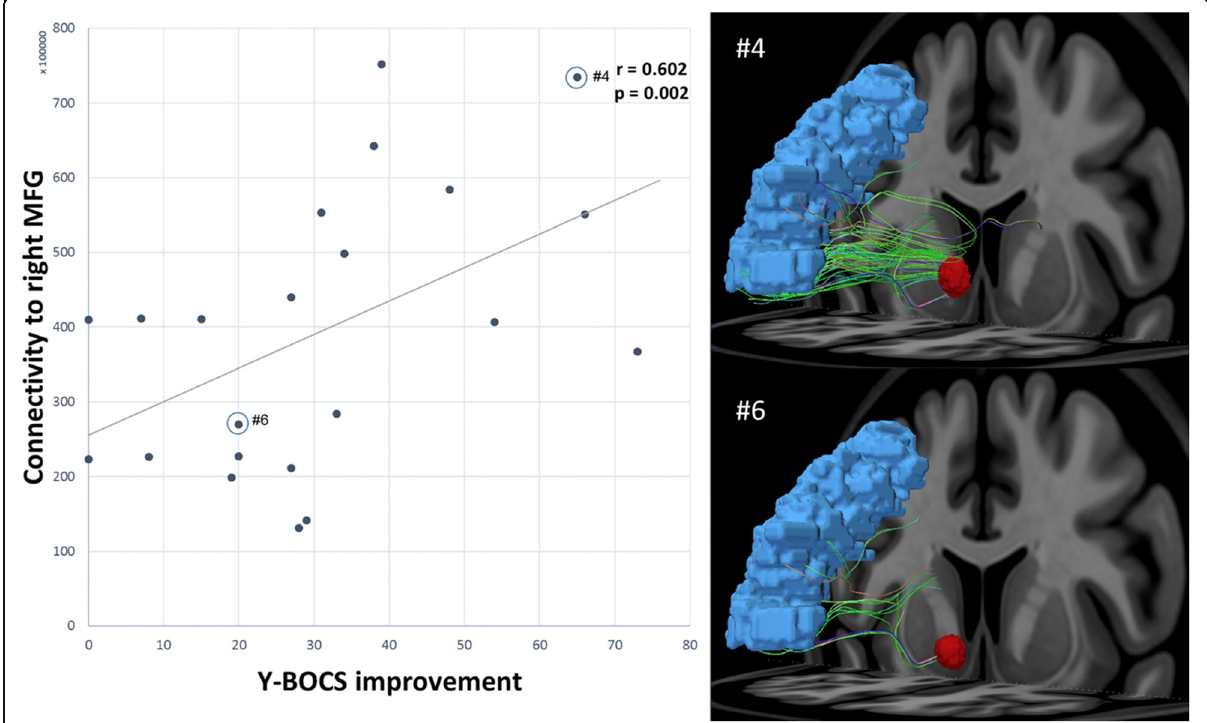
Fig. 5 Correlation of clinical outcome and connectivity to cortical regions of interest. Left panel: Connectivity of stimulation sites to the right middle frontal gyrus (MFG) associated positively with clinical outcome after 12 months of DBS. Right panel: Patient 4 exhibited more robust clinical outcome to DBS with greater connectivity to the caudal part of the MFG region. Patient 6 showed less robust clinical outcome to DBS with relatively sparse connectivity. [Reprinted from Biological Psychiatry 85 (9): 735 – 743, Baldermann JC, Melzer C, Zapf A, Kohl S, Timmermann L, Tittgemeyer M, Huys D, Visser-Vandewalle V, Kuhn AA, Horn A, Kuhn J. Connectivity profile predictive of effective deep brain stimulation in obsessive-compulsive disorder. Copyright (2019), with permission from Society of Biological